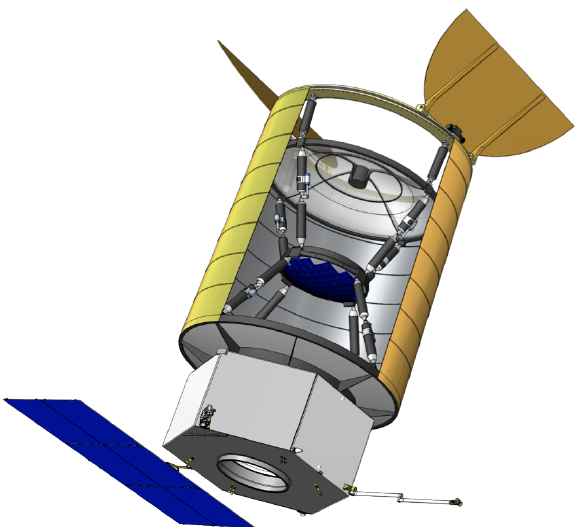
Figure 2. A schematic of a POEMMA Schmidt satellite with the light doors open and with the light shield cut away to show the Schmidt telescope